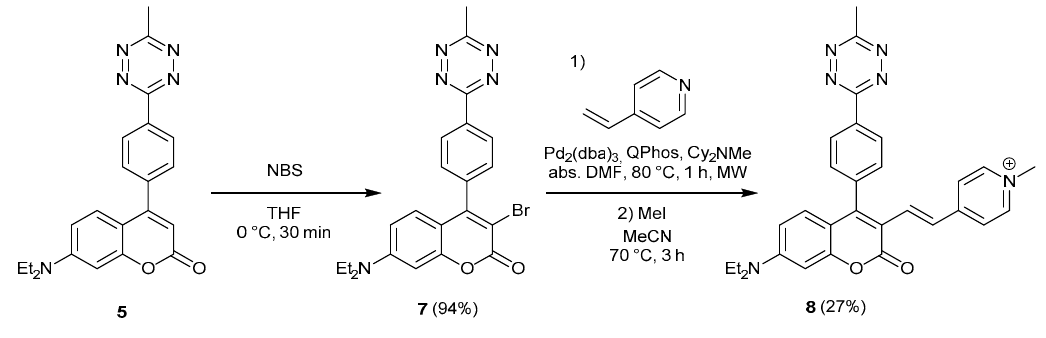
Scheme 3. Synthesis of π -extended HELIOS-like probe 8 . Table 1. Main photophysical data of probes 5 , 6, and 8 and their (1 R ,8 S ,9s)-Bicyclo[6.1.0]non-4-yn-9- ylmethanol (BCN) conjugates. 1